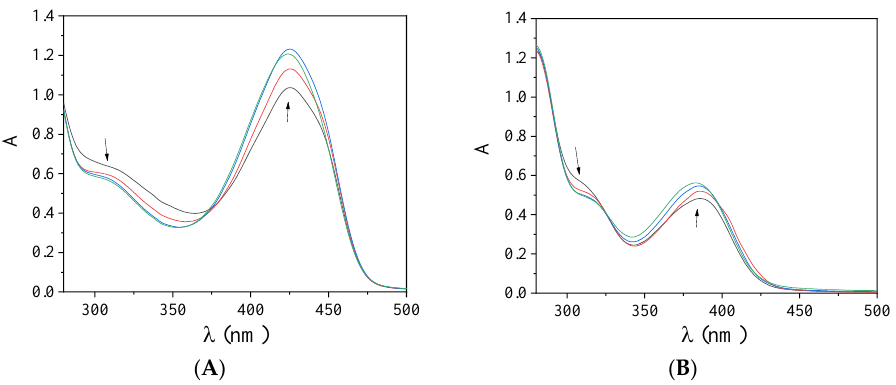
Figure 3. UV-vis spectra of DMSO solution of ( A ) 2 (10 − 4 M), ( B ) 5 (10 − 4 M) in the presence of increasing amounts of CT DNA. The arrows show the changes upon increasing amounts of CT DNA.